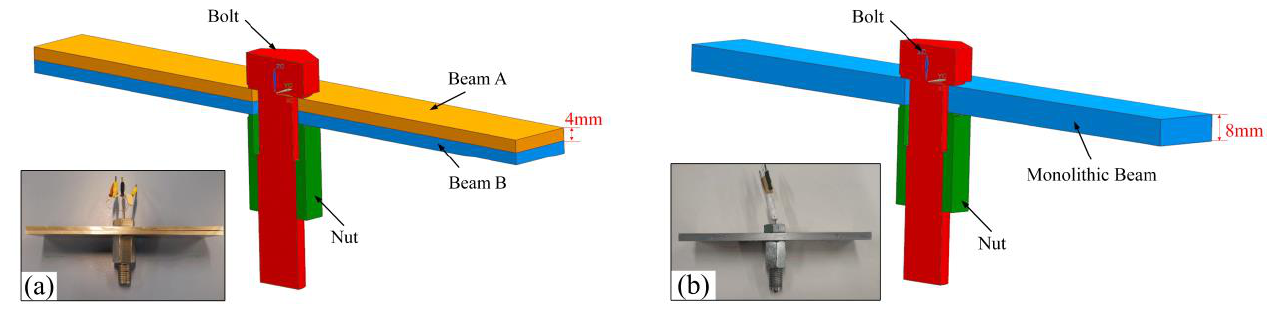
Figure 4. Comparison of the two experimental setups: ( a ) two-beam joint, and ( b ) one monolithic